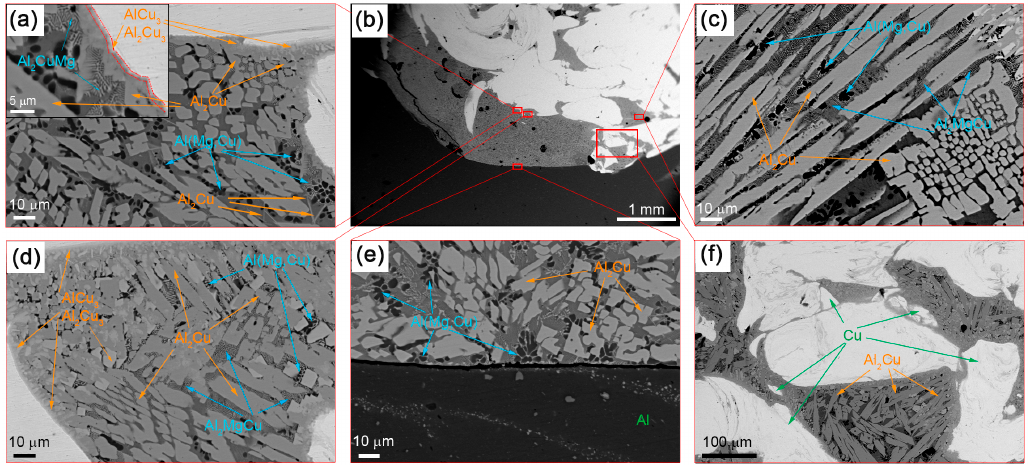
Figure 4. The SEM BSE images of SZ microstructures after a single-pass FSP on the Al-Cu sandwich: ( a ) SS/IMC interface; ( b ) stir zone macrostructures; ( c ) column IMCs; ( d ) IMCs of different compositions; ( e ) substrate/stir zone boundary; ( f ) mixed IMC + SS zone.